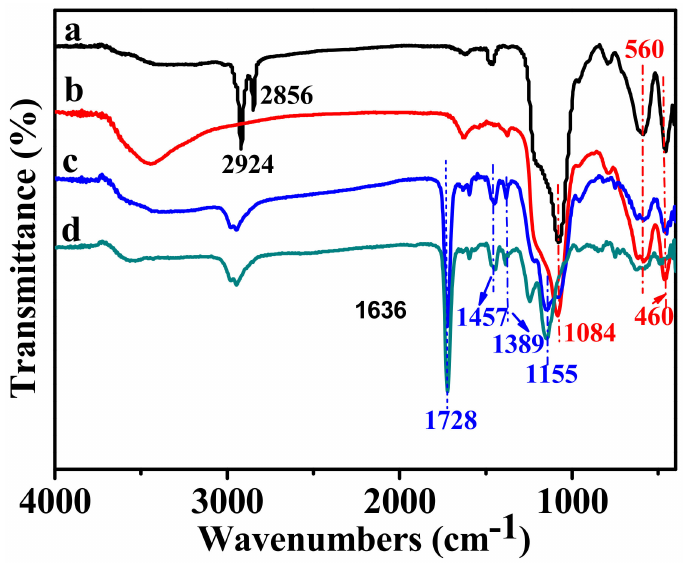
Figure 1. FT-IR spectra of Fe 3 O 4 @mSiO 2 /CTAB ( a ), Fe 3 O 4 @mSiO 2 ( b ), Fe 3 O 4 @mSiO 2 @MIPs ( c ), and magnetic porous molecularly imprinted polymers (MPMIPs) ( d ).